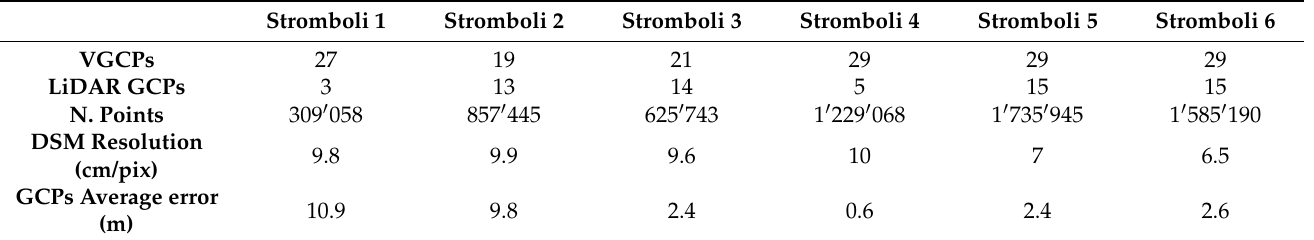
Table 2. UAV-based photogrammetric survey specifications and product characteristics after the finest realignment processing.